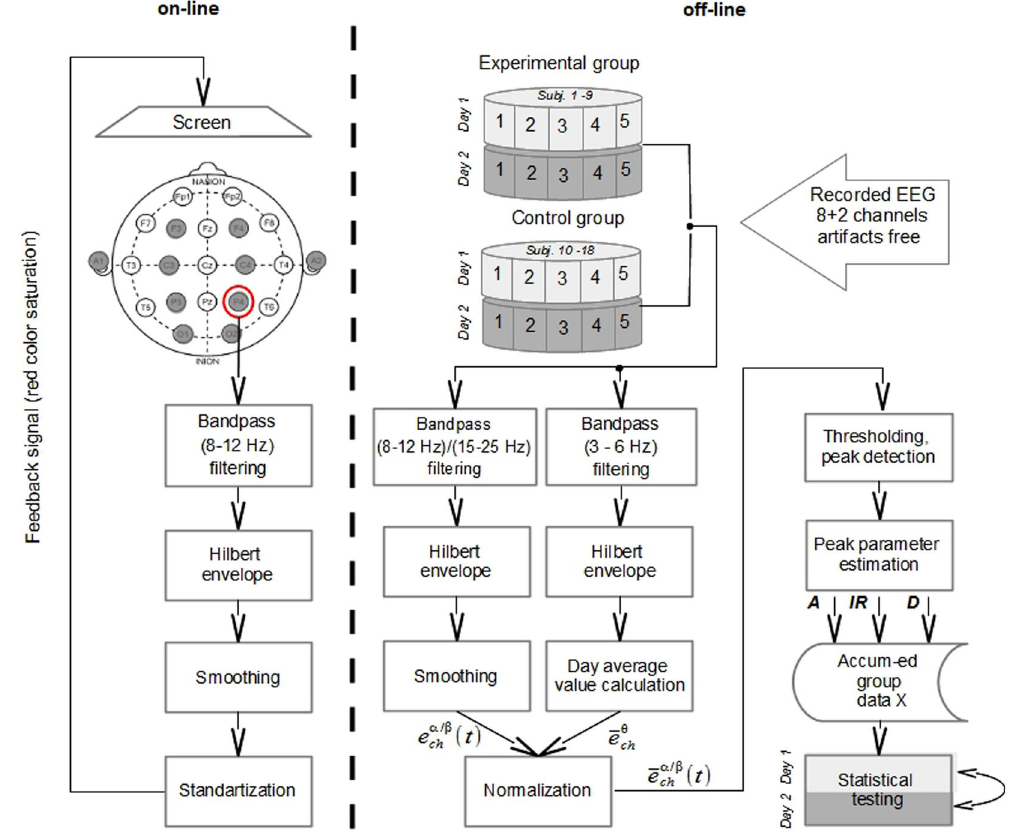
Figure 2. Schematic representation of the experimental